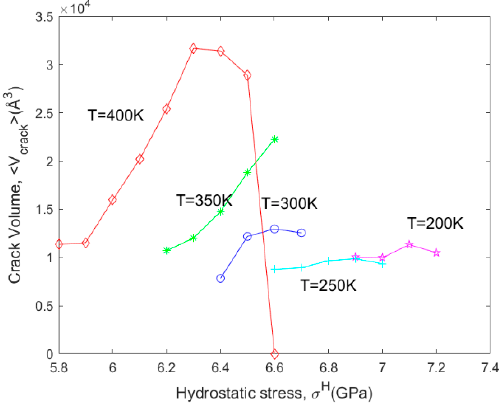
Figure 9. Average crack volume among 10 replicas at the moment of dislocation nucleation as a function of hydrostatic stress over temperatures ranging from 200 to 400 K.